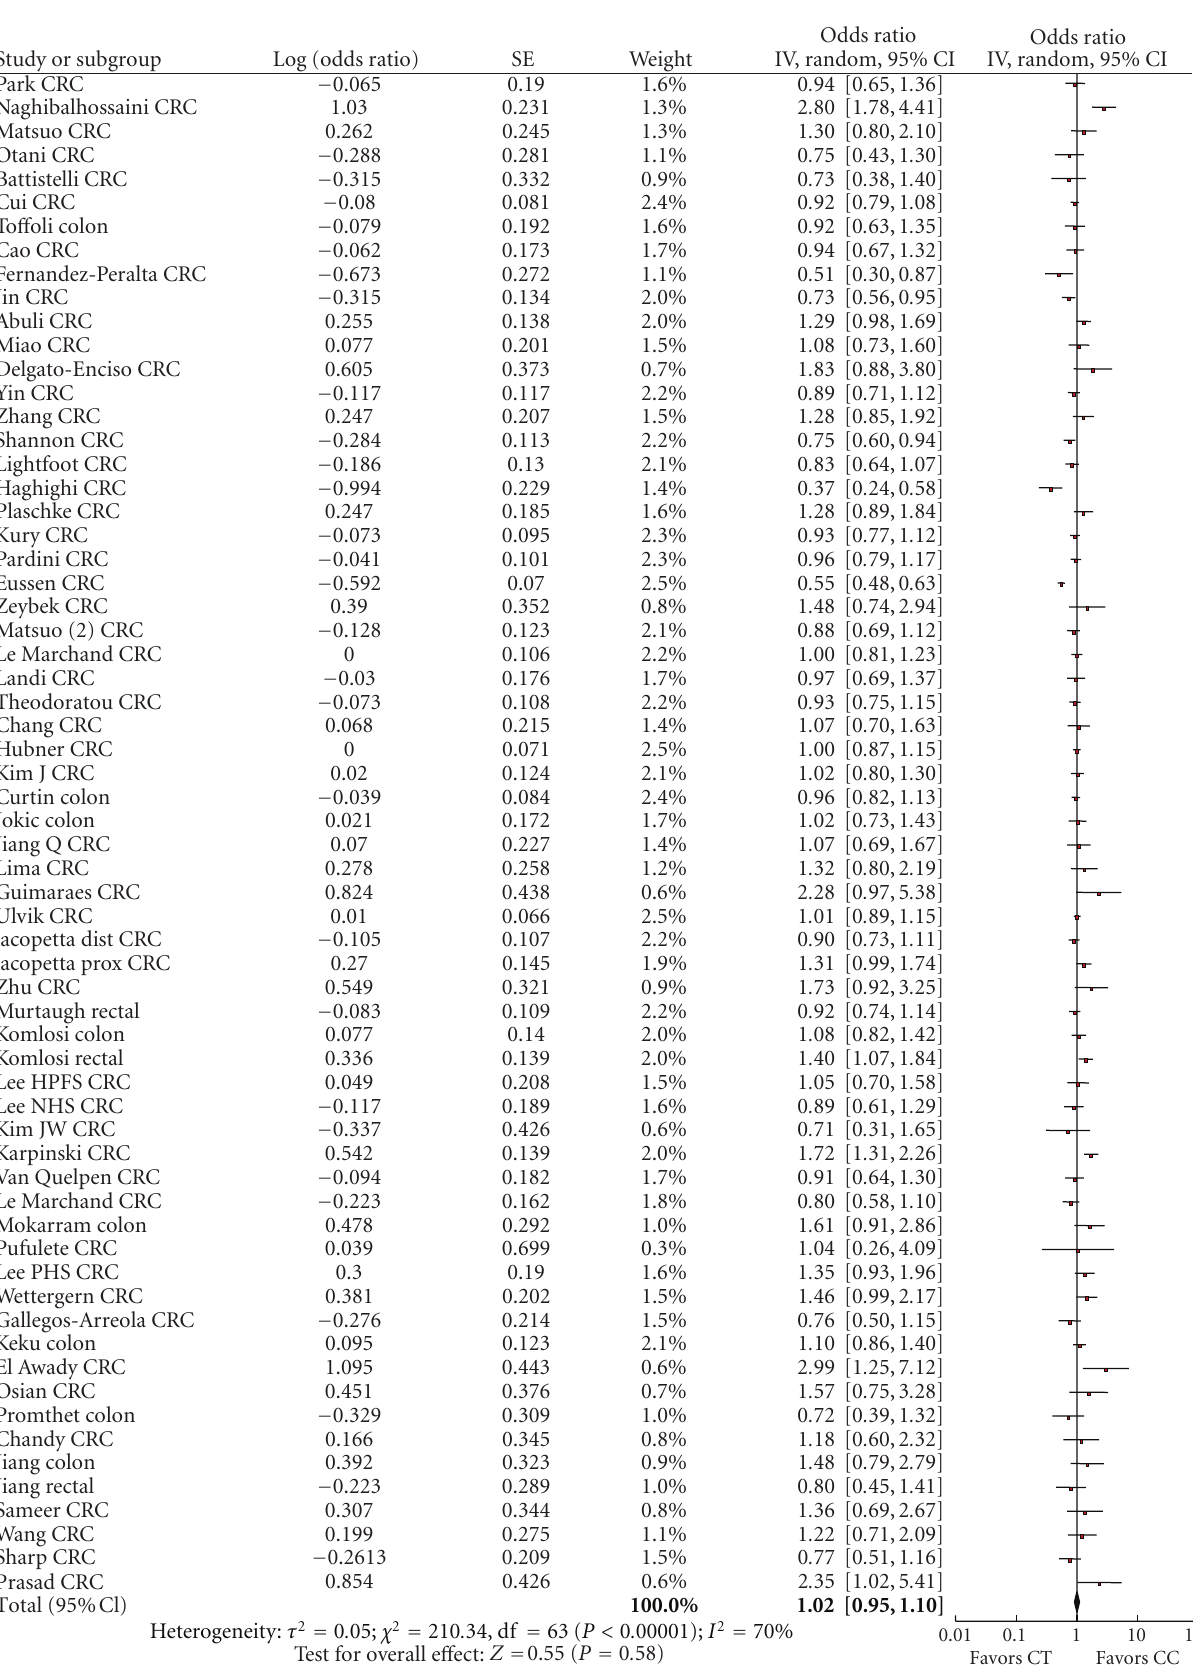
Figure 2: Forest plot of the risk of colorectal cancer for MTHFR 677 CT versus